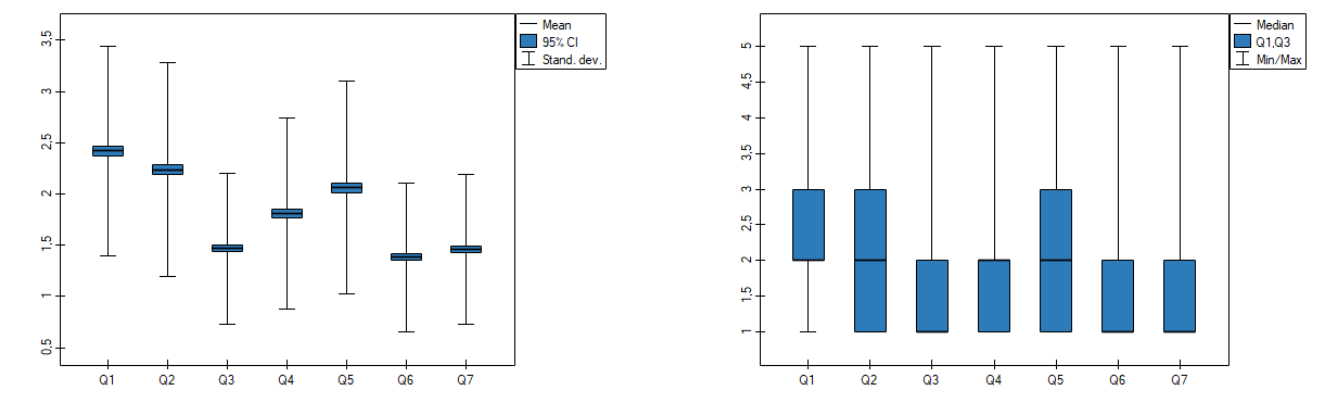
Figure 1. Mean and median level of fear. Source: own study based on research.